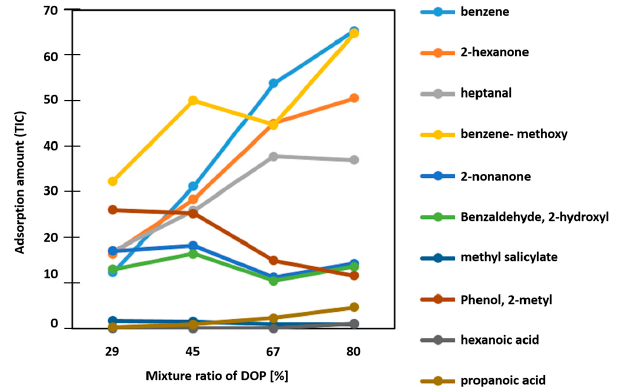
Figure 5. Adsorbed odorant amount (TIC: total ion current obtained from gas chromatography–mass spectrometry/solid-phase microextraction) of polyvinyl chloride–dioctyl phthalate (PVC-DOP) adsorbents as a function of DOP content.